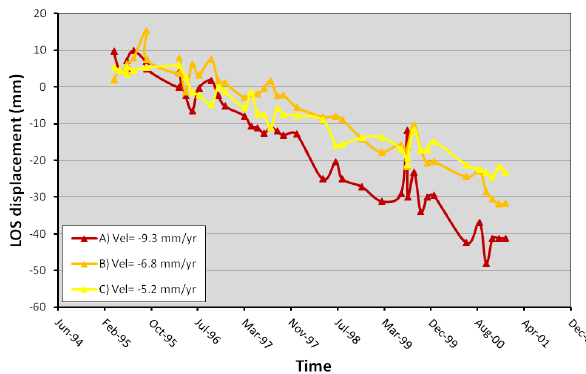
Figure 10. Displacement time series and yearly velocities of PS A, B, and C (Fig.9), located 847 Fig. 10. Displacement time series and yearly velocities of PS A, B, and C (Fig. 9), located close to the damaged area of Perea close to the damaged area of Perea village. 848